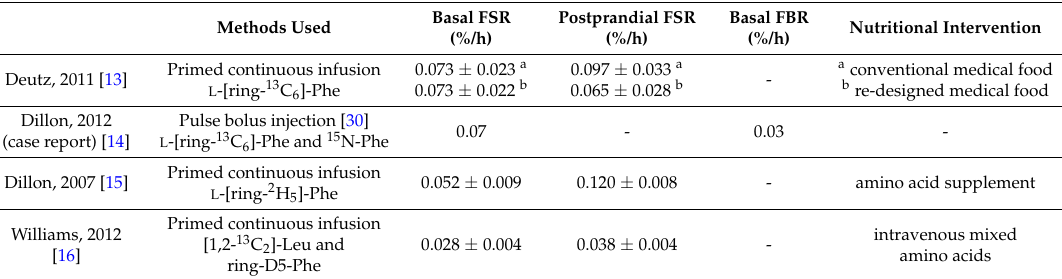
Table 1. Muscle protein synthesis and breakdown rates in cancer patients.